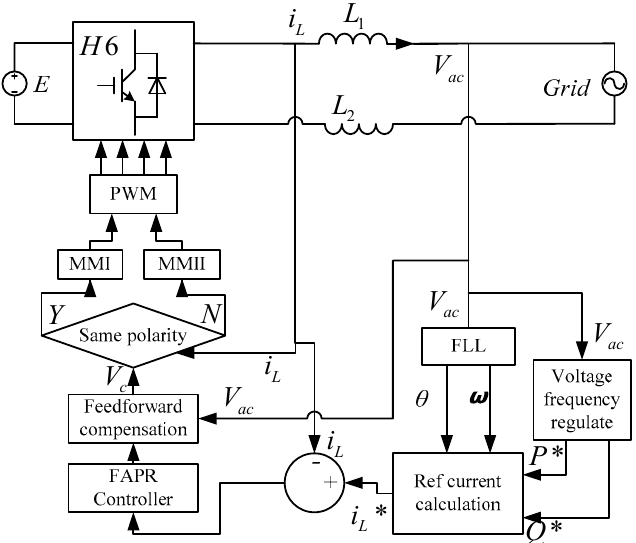
Figure 10. The block diagram of control with the new HMM.